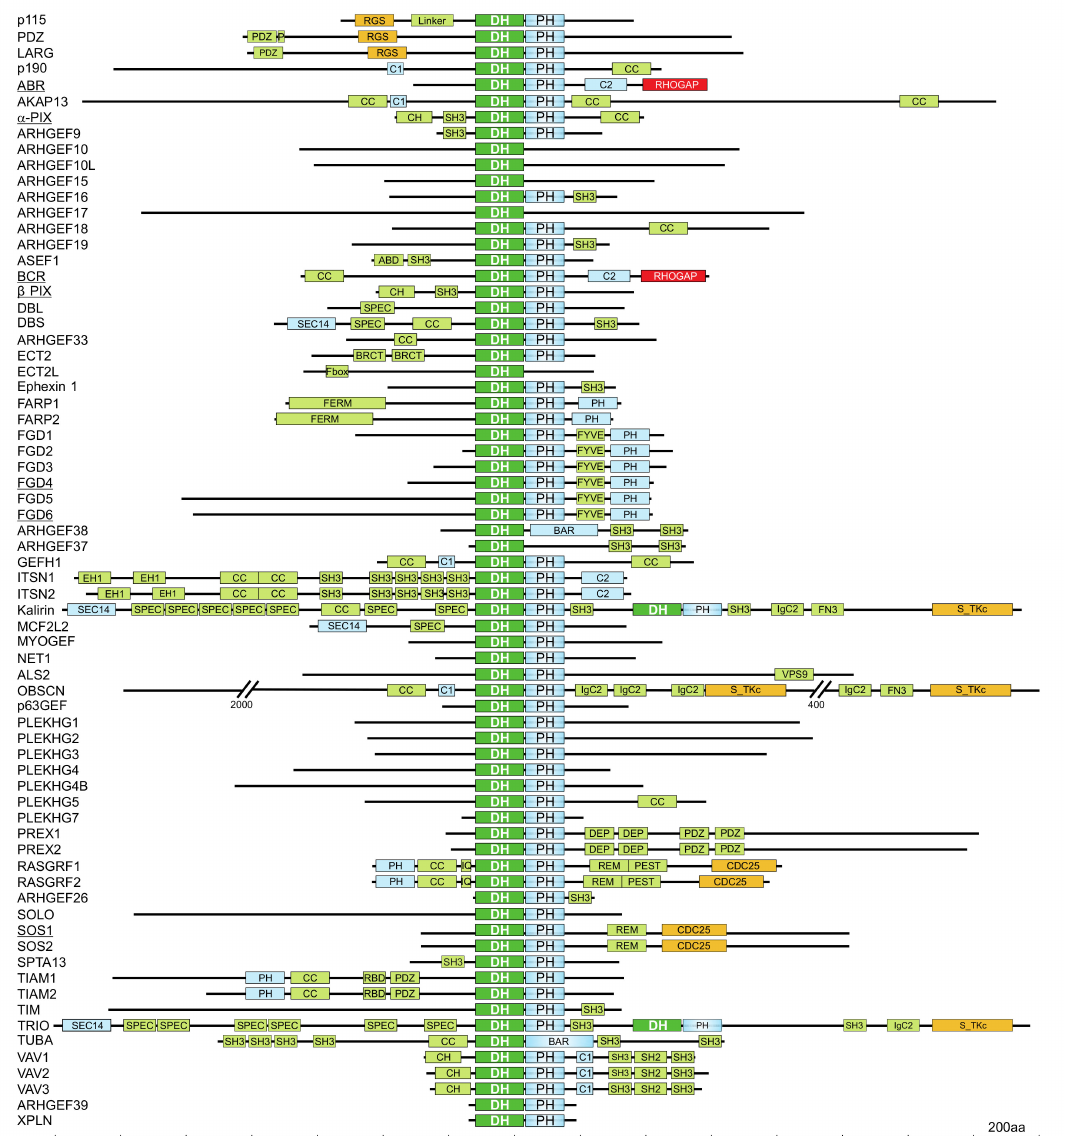
Figure 3. Domain organization of DBL family proteins. The DBL family RHOGEFs are mostly multimodular proteins and have a number of functional domains that may mediate cross talk between RHO proteins and other signaling pathways. DH domains are almost always found with a PH domain in the C-terminus. Some DBL proteins contain two DH–PH cassettes, while some DBL proteins lack tandem PH domains. Functional domains, in addition to the catalytic DH domain (green), are probably involved in lipid and membrane binding (blue), protein interactions (bright green), and enzymatic activities (red and orange). A scale of amino acid numbers in increments of 200 is shown at the bottom. Underlined proteins do not exhibit activity under cell-free conditions